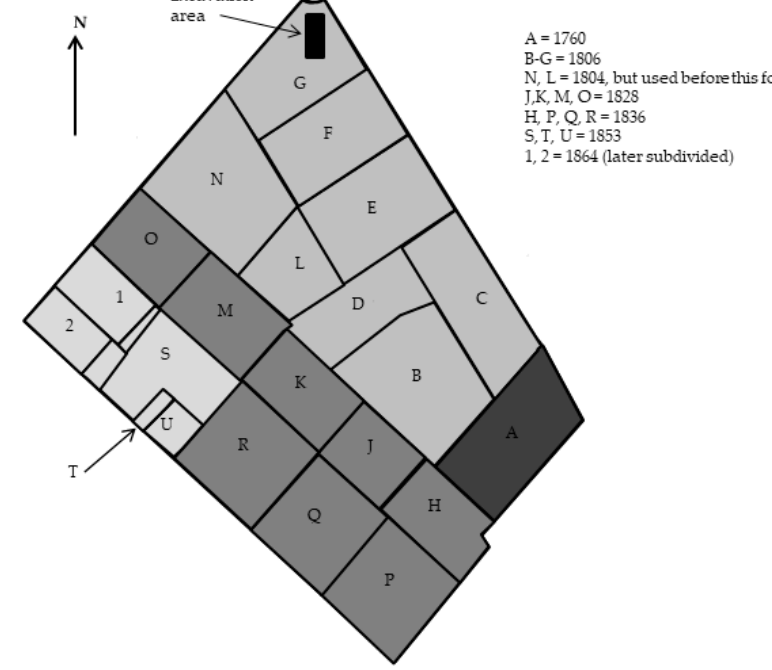
Figure 1. Chronological development of Assistens cemetery, Copenhagen by the year each Division or area in the cemetery is established. The excavation took place in Division G.